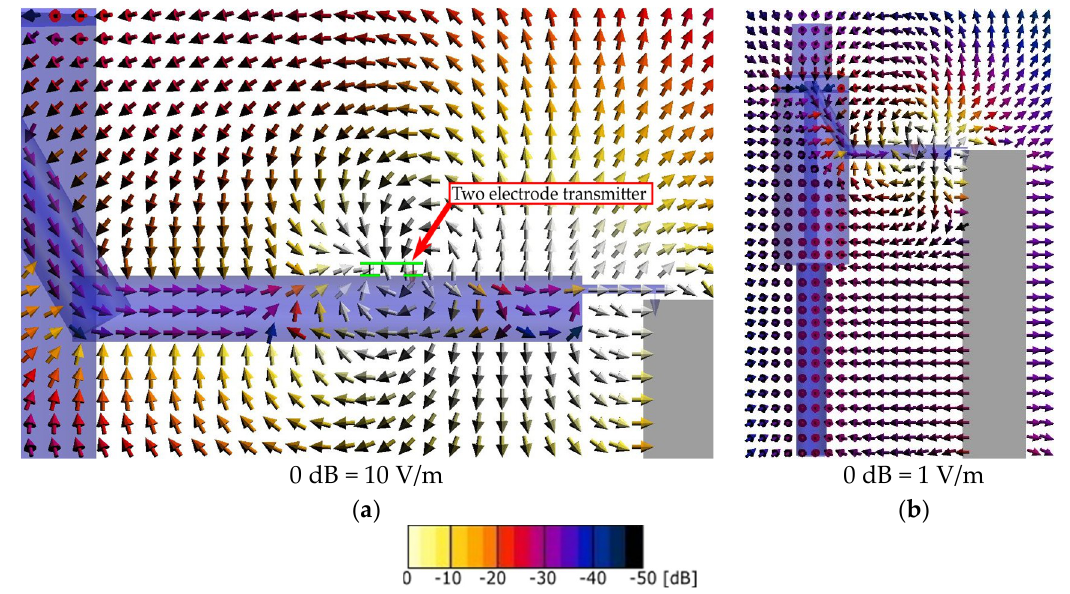
Figure 6. Direction and strength of the electric field in the two-electrode transmitter case. ( a ) Distribution around the transmitter and the arm. ( b ) Distribution viewed in a wider area including the whole human body.